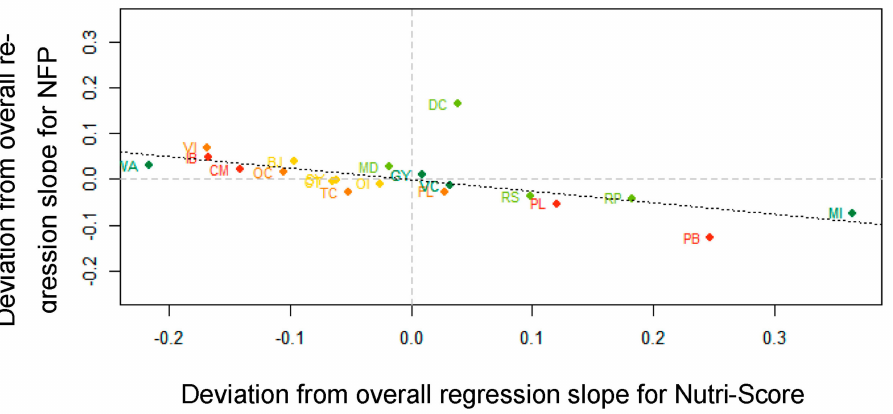
Figure 7. Correlation ( r = − 0.62) between by-stimulus deviations from overall regression slope for Nutri-Score and by-stimulus deviations from overall regression slope for NFP. Abbreviations of the product names are explained in Figure 4 and in Appendix A (Table